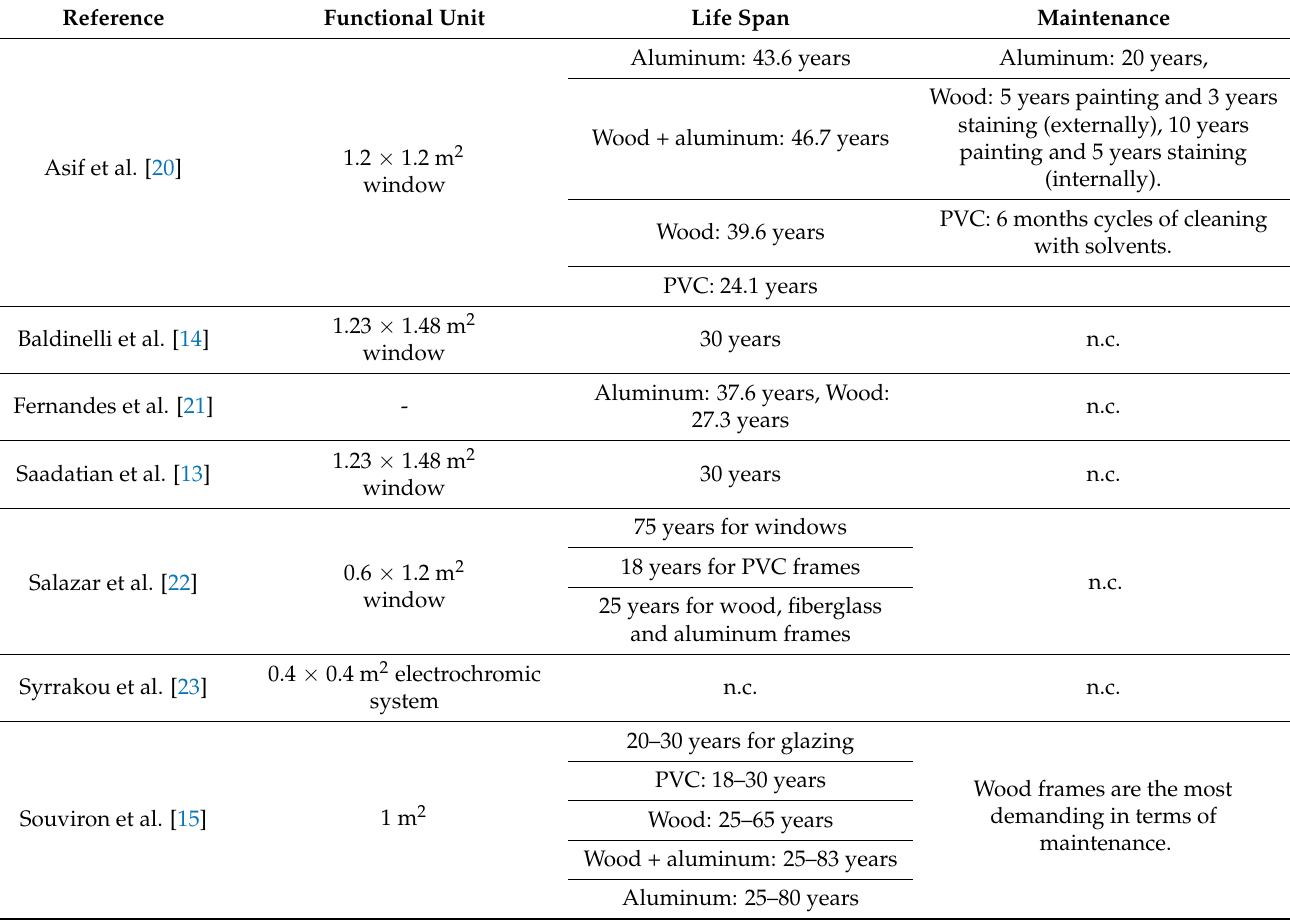
Table 1. Assumptions made by the analyzed literature